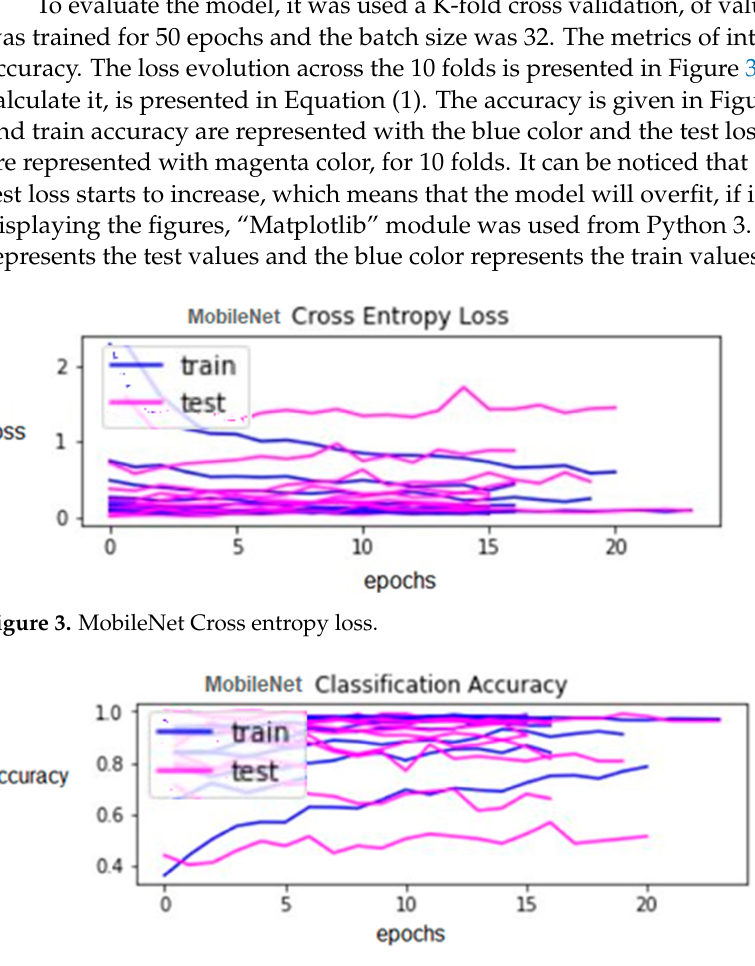
( b ) Figure 5. ResNet-50 and VGG16 Cross entropy loss. VGG16 had a mean accuracy of 59.867% and a standard deviation of 0.085. Though the standard deviation is lower than the MobileNet’s one, the accuracy is still under the MobileNet’s. VGG16 mean loss was 1.006 which is lower than ResNet-50 ′ s, but bigger than Mo- bileNet’s. The loss’s values are presented in Figure 5b. Due to the model results and to its low complexity, MobileNet model was selected to be incorporated in the PandaSays mobile application. For evaluating the model, was used sklearn library. The code was written in Python 3 programming language. To calculate the evaluation of the model was taken into account the number of folds (10), the mobile net model, the batch size of 32 and the number of epochs, which was 50. For calculating the mean and the standard deviation, was used “numpy” module from Python and predefined methods: std (standard deviation) and mean. The model performance is presented in Figure 6. The mean accuracy is 84.583% and the standard deviation is 0.14, for 10 folds, which means that the majority of the values are within the range of 0.14 from the mean value of 84.583%. The mean accuracy was calculated summing all the accuracy results obtained from the model training, with 10 folds and divided the sum to 10. In our previous work [26], the accuracy obtained was 56.25%, fact that emphasizes the improvement of the work.